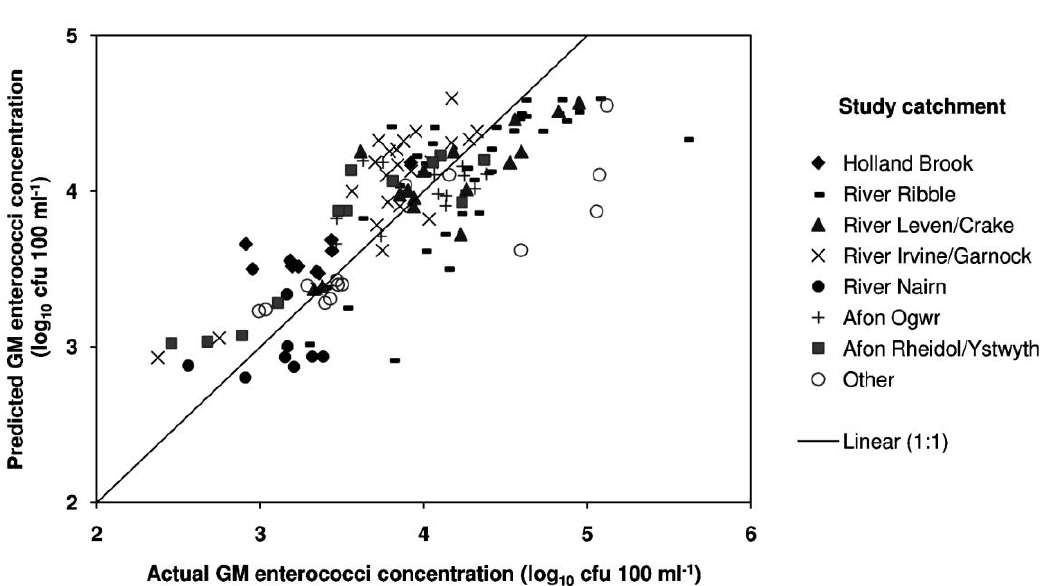
Figure 2. Plot of actual high-flow log geometric mean enterococci concentration against 10 predicted values using population-based model reported in Table 6, with values from those studies showing clear +ve or –ve anomalies from transferability testing (Table 7)